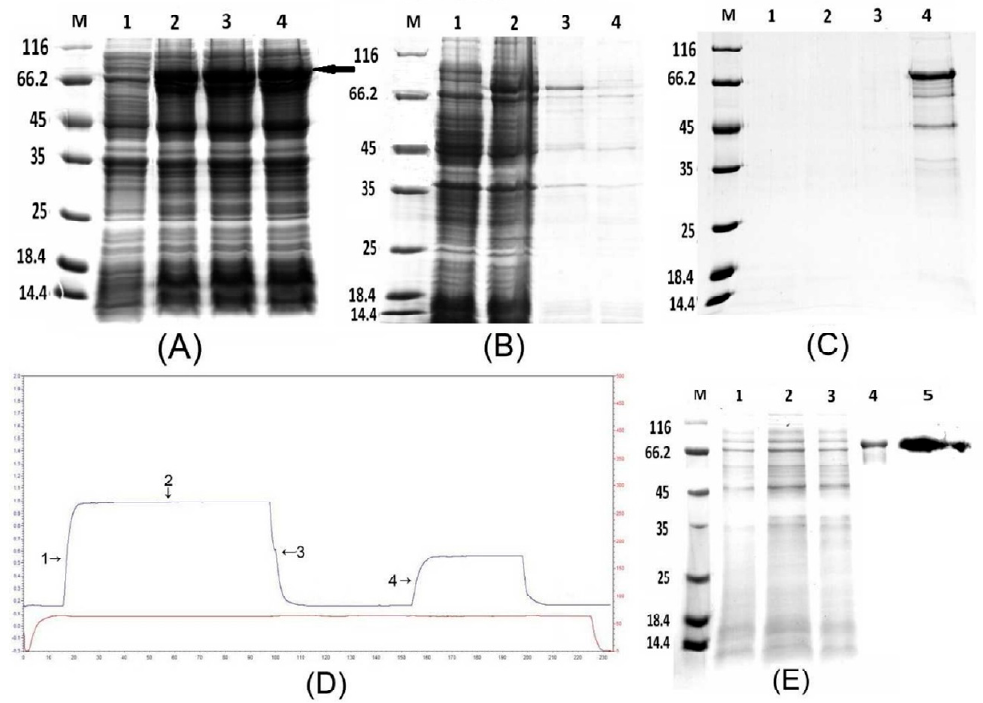
Figure 3. ( A ) Analysis of the fusion protein by 12% SDS-PAGE. Lane M: molecular mass marker; lane 1: negative control; lanes 2–4: colonies 1–3 (induced with 1 mM IPTG). The molecular weight of the target protein was approximately 78.6 kDa (black arrow). ( B ) Analysis of the supernatant and precipitate by SDS-PAGE. Lane M: molecular mass marker; lane 1: negative control; lane 2: colonies induced by 1 mM IPTG; lane 3: precipitate; lane 4: supernatant. ( C ) Denaturation of PtDXS. Lane M: molecular mass marker; lane 1: 2 M urea; lane 2: 4 M urea; lane 3: 6 M urea; and lane 4: 8 M urea. ( D ) Ni-IDA affinity chromatography of the fusion protein. Marks 1 and 2: flow-through; mark 3: wash; and mark 4: elution. ( E ) Purification of PtDXS. Lane M: molecular weight marker; lanes 1, 2: flow-through; lane 3: wash; lane 4: elution; lane 5: western blot analysis of purified PtDXS using a monoclonal antibody against the 6 × His tag.